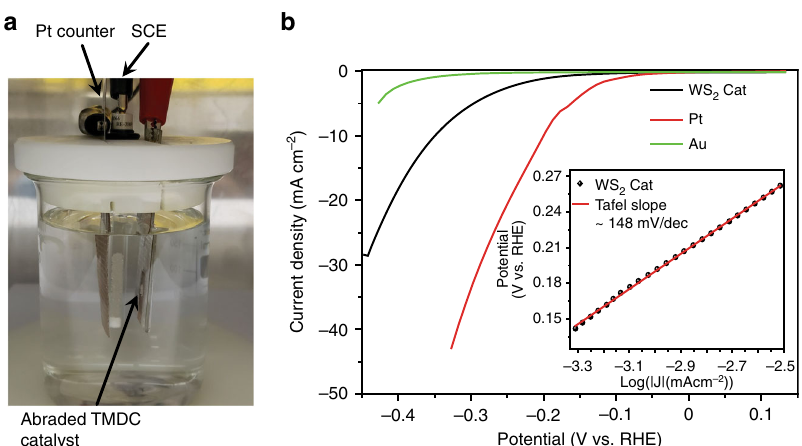
Fig. 3 WS 2 fi lms as a catalyst for hydrogen evolution. a Optical micrograph of the electrochemical cell highlighting the different electrodes. b Polarisation curves comparing Pt, Au and abraded WS 2 measured in 0.5 M H 2 SO 4 with a scan rate of 2 mV/s at room temperature. The inset shows the Tafel plots for our WS 2